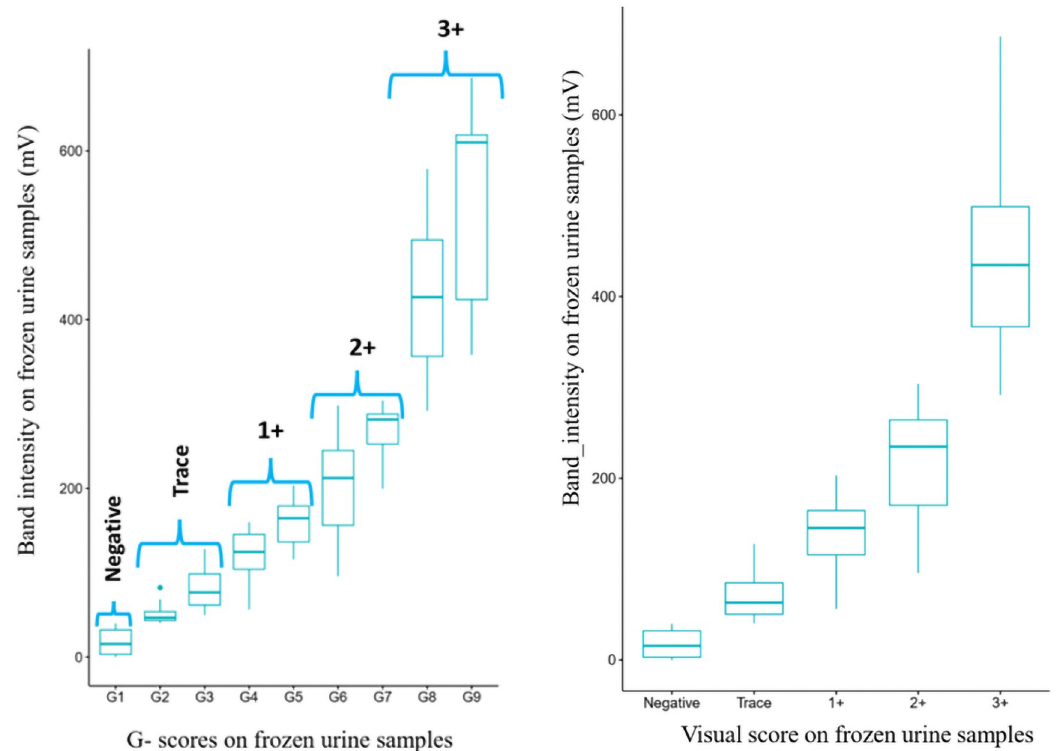
Fig 6. Correlation between infection intensity from the POC-CCA tests using the ESEquant reader and the visual scoring system (Fig 6A: G-scores; Fig 6B: Corresponding visual score).